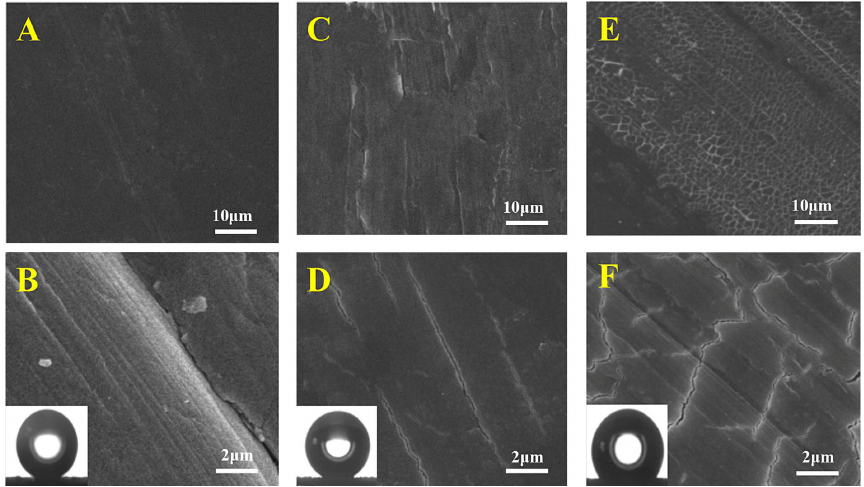
Figure 3. SEM micrographs of corrosion resistant superhydrophobic samples after being loaded for 20,000 friction tests ( A , B ), 100,000 friction tests ( C , D ) and 1,800,000 friction tests ( E , F ). Reprinted from [67] with permission; Copyright Elsevier 2015.